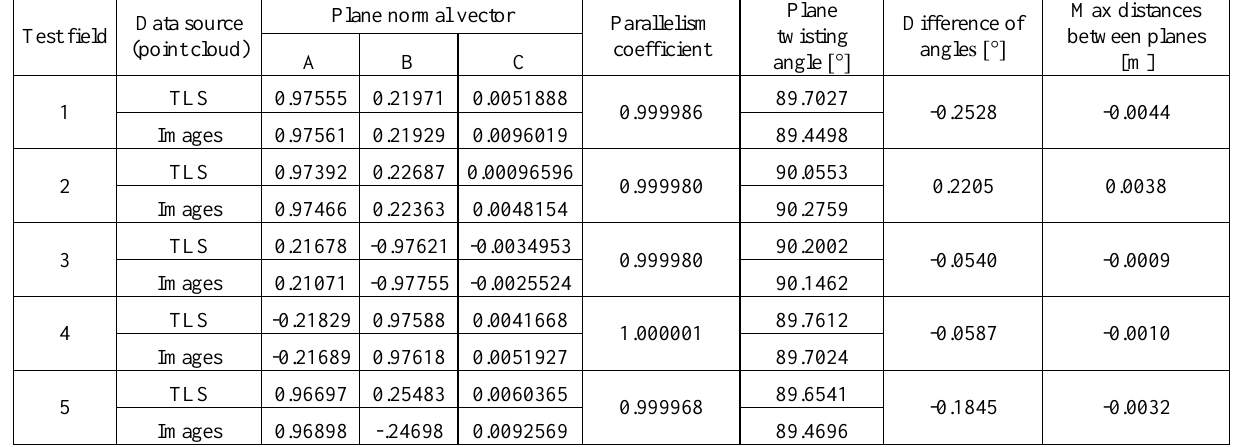
Table 7. The example parameters used for plane parallelism analysis (Epoch